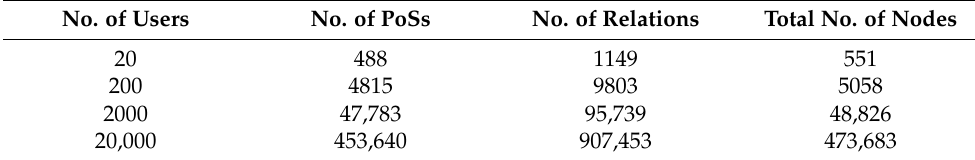
Table 4. Details of stored semantic indoor movement trajectory in the Neo4j graph